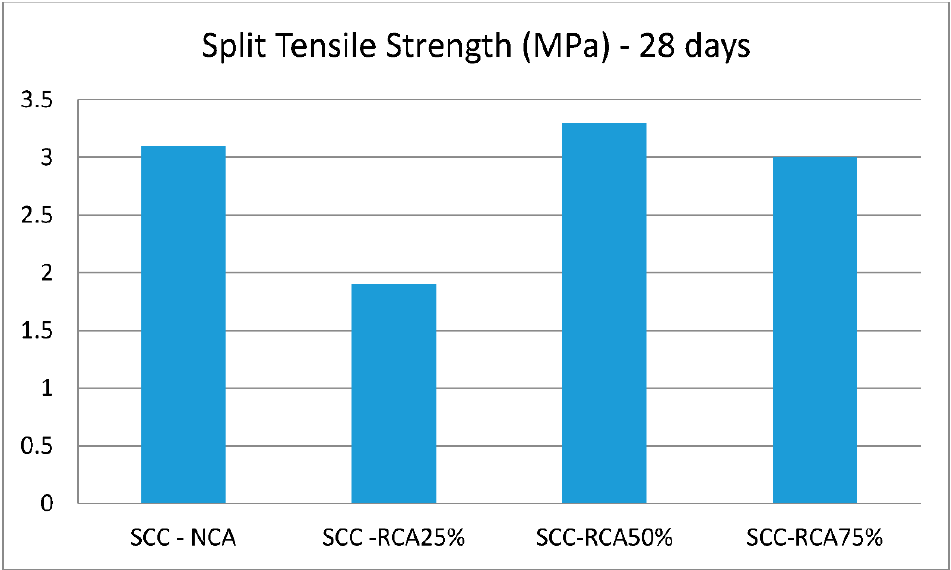
Figure 9. Split Tensile Strength of Concrete.